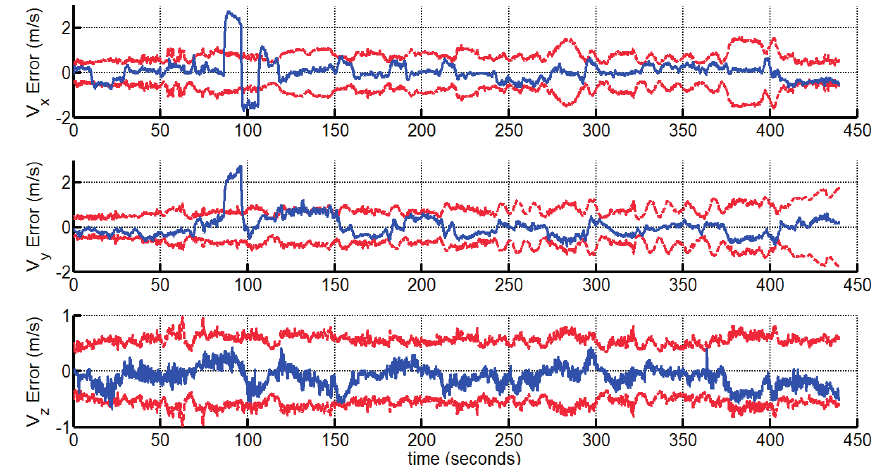
Figure 5. The velocity estimation errors and 3 σ bounds (the large deviations around 100th second is due to the ground truth